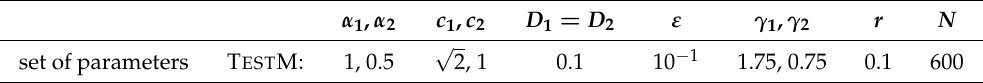
Table 4. In this table, we define the two sets of parameters in Equation (40).